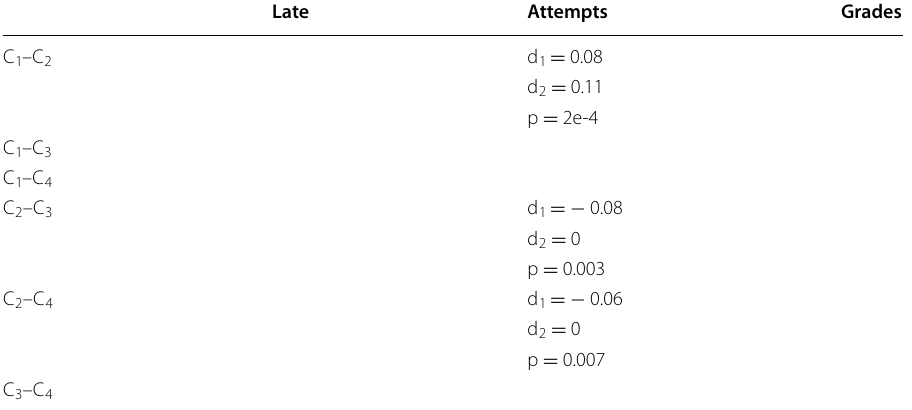
Table 10 By clusters: overall